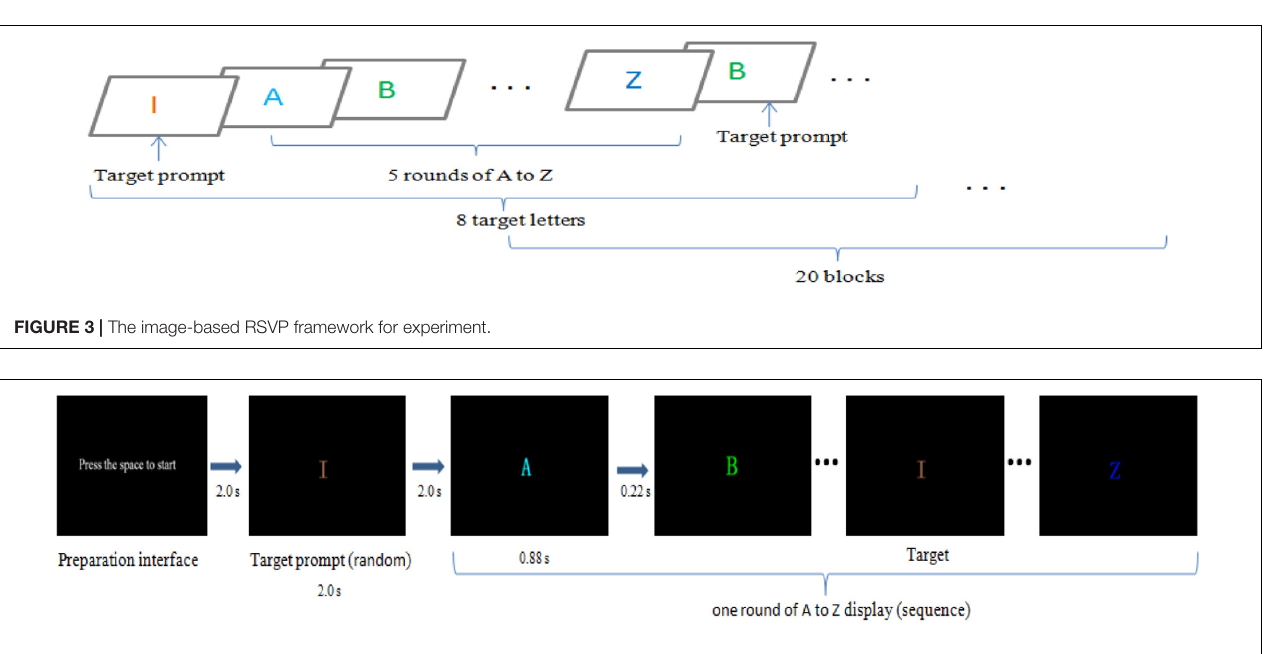
FIGURE 4 | The RSVP paradigm in one